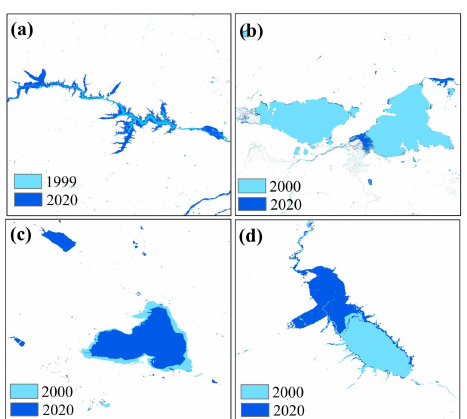
Figure 12. Typical surface water extent in the YRB in 2000 and 2020. (a): Xiaolangdi; (b): Zhaling and Eling Lake; (c): Hongjiannao Lake; (d): Fenhe